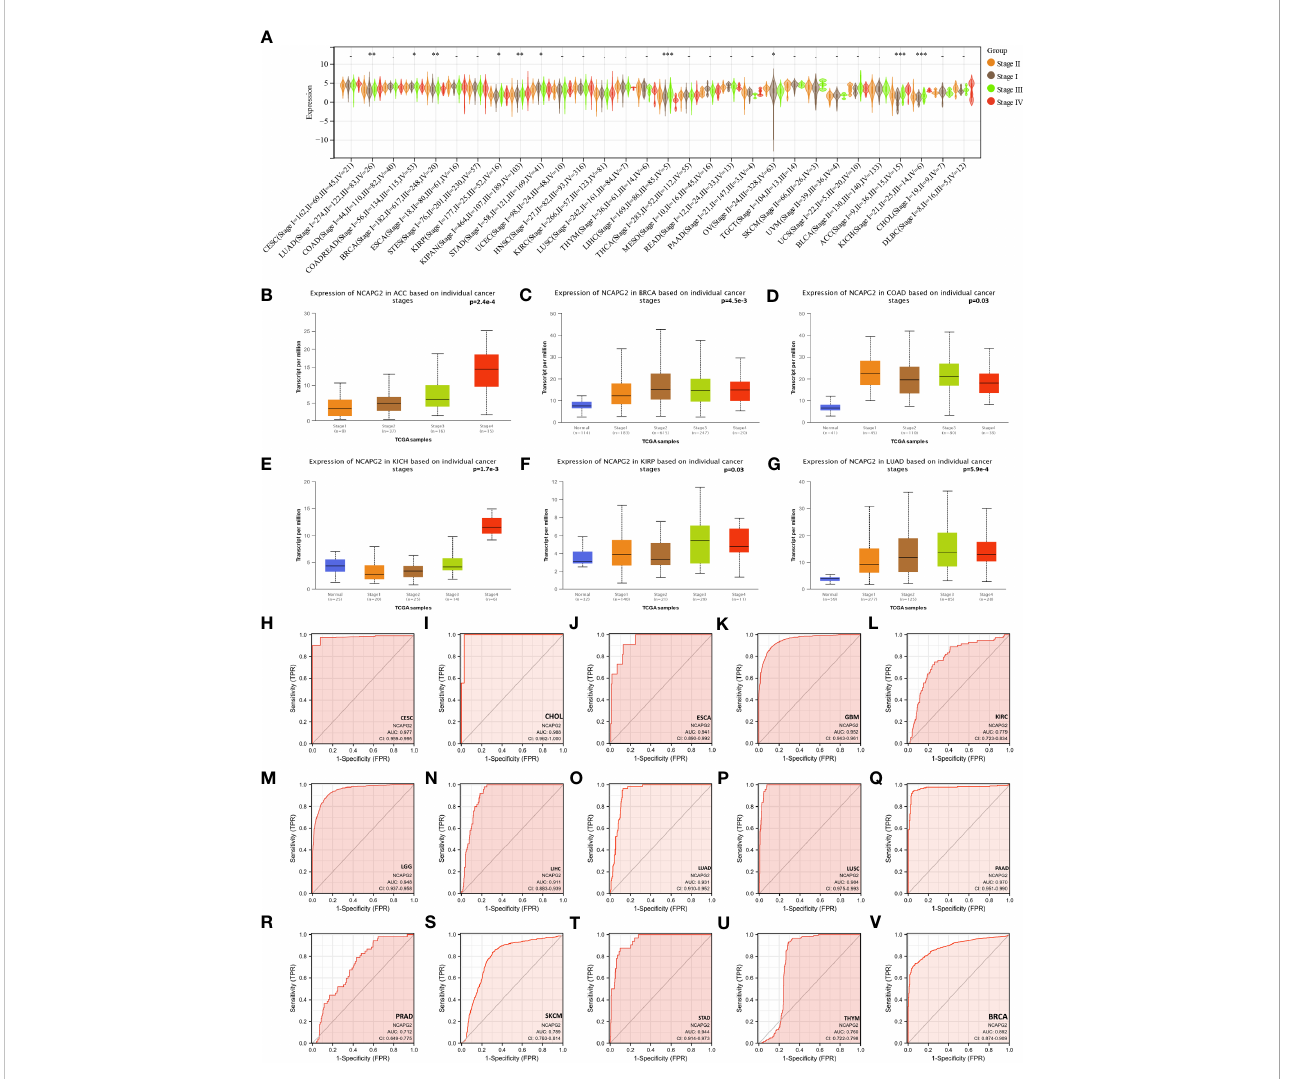
FIGURE 3 The relationship between NCAPG2 and stages and its diagnostic value. (A) Expression levels of NCAPG2 at distinct stages in pan-cancer; (B – G) NCAPG2 expression at diverse tumor stages in ACC, BRCA, COAD, KICH, KIRP, LUAD; (H – V) ROC curves for NCAPG2 in pan-cancer. *p<0.05; **p<0.01;